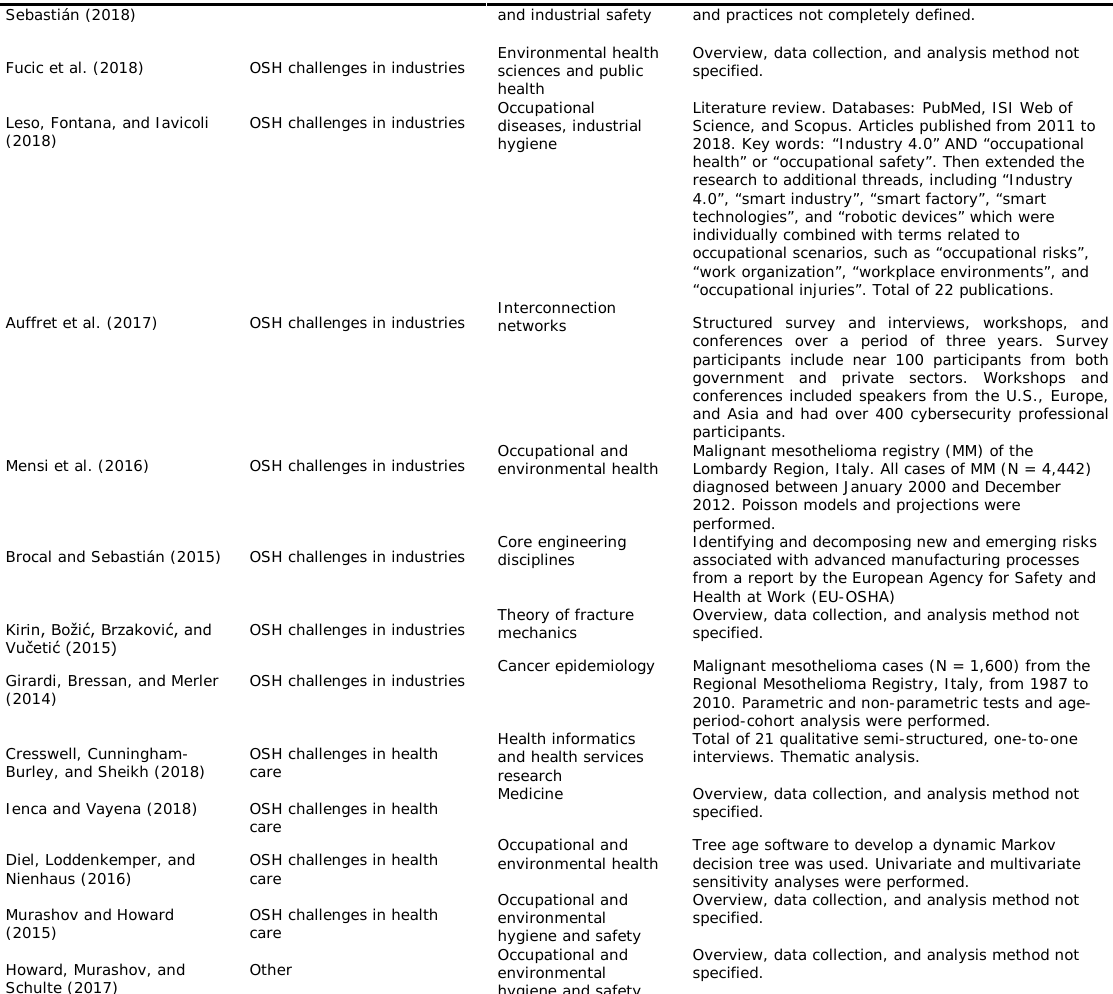
Overview, data collection, and analysis method not specified.